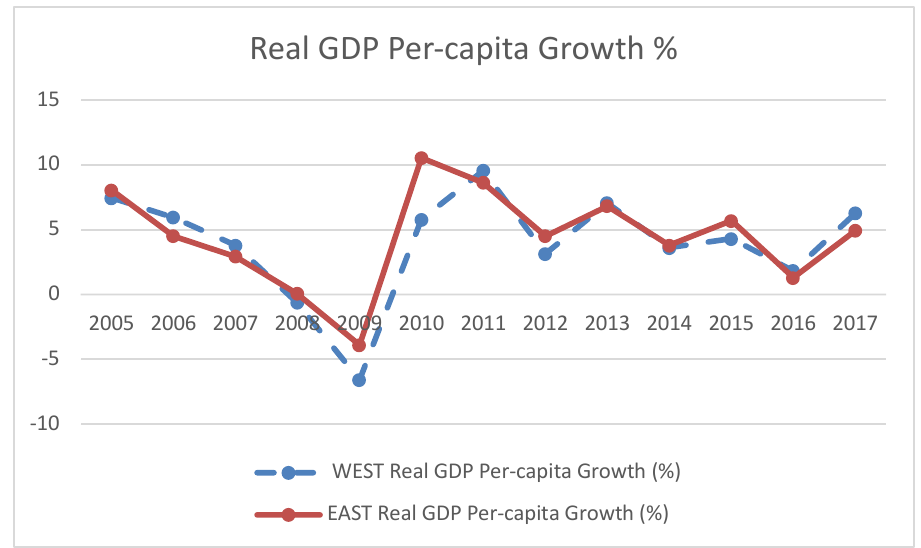
Figure 5: West-East Real GDP Per-capita Growth